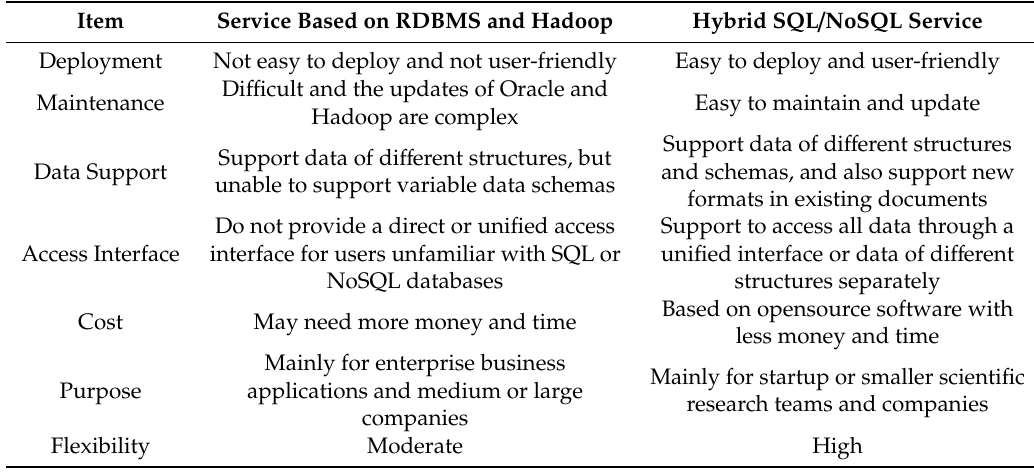
Table 1. Comparison of di ff erent SOOC data services.